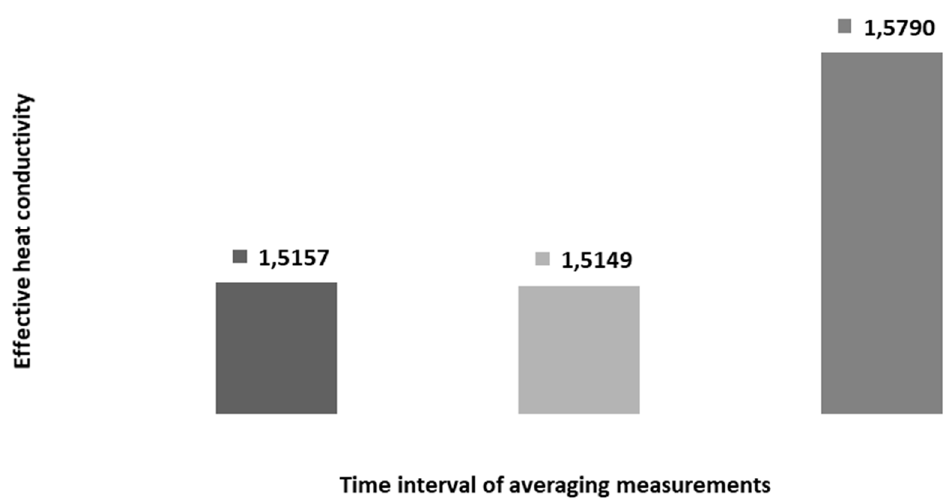
Figure 14. E ff ective thermal conductivity λ e ff depending on time interval for BHE-5 (double Figure 14. Effective thermal conductivity λ eff depending on time interval for BHE-5 (double U-pipe).